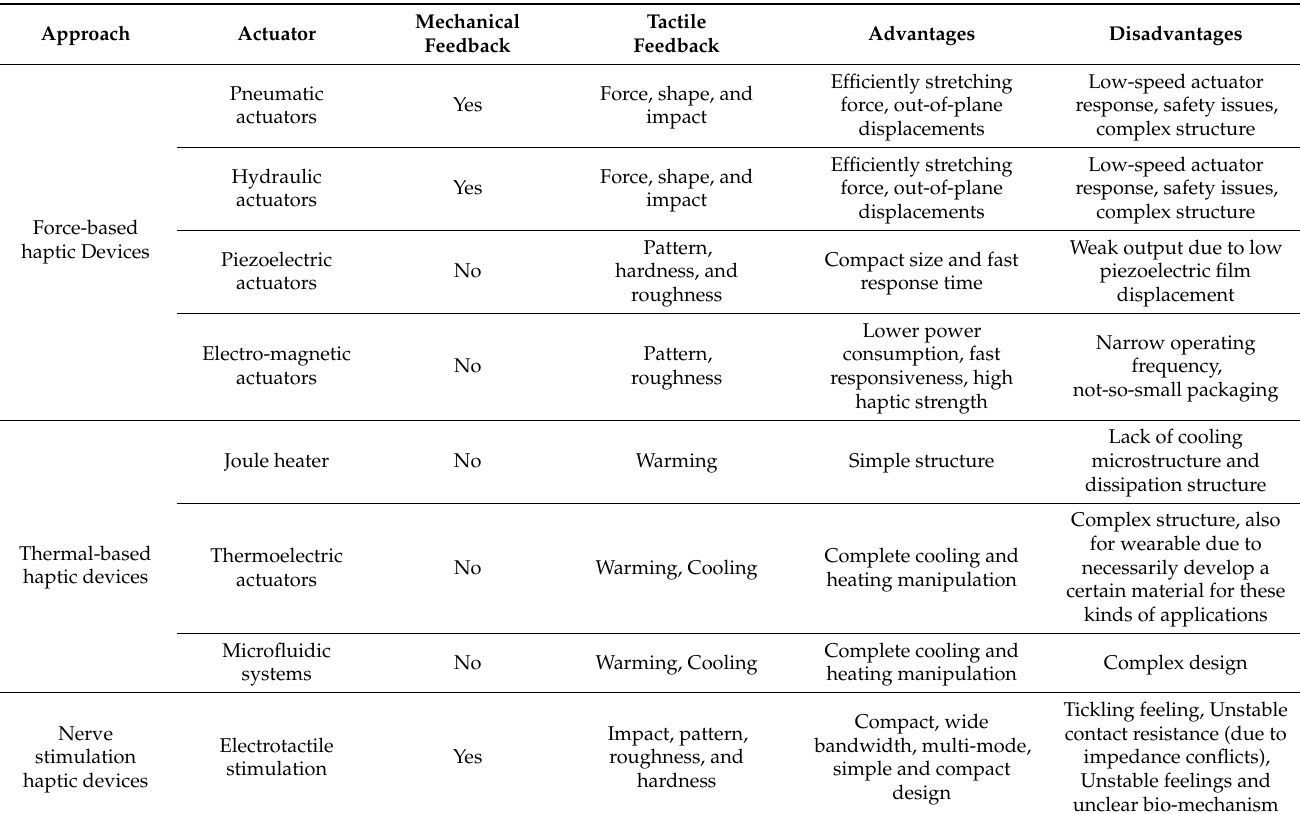
Table 1. Summarizing and comparative table of the discussed haptic